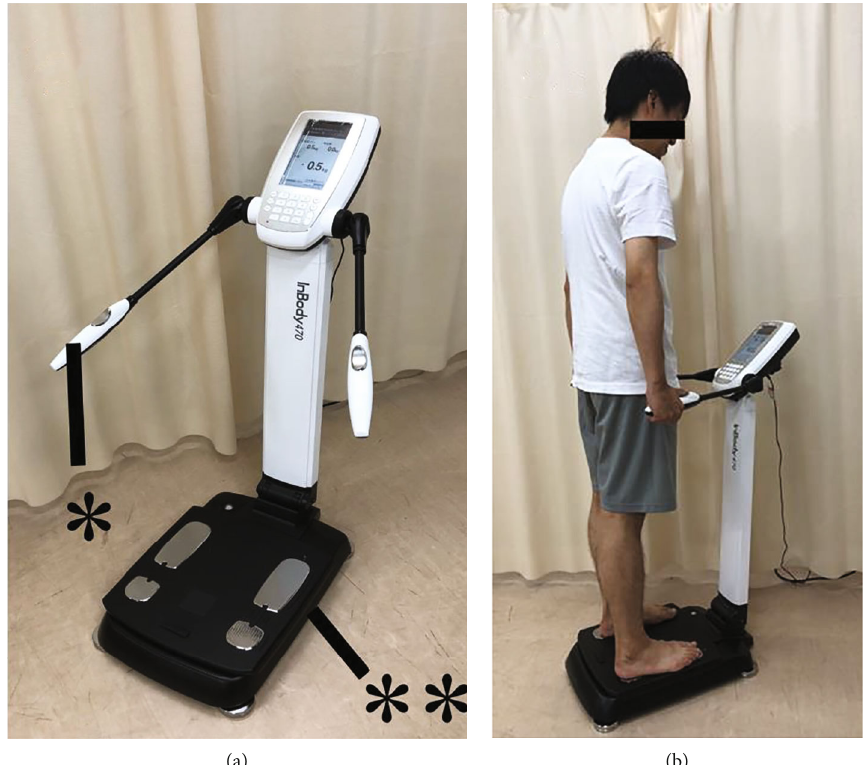
Figure 1: Method for measuring body composition. (a) Image of the InBody 470®; ∗ : hand electrodes; ∗∗ : foot electrodes. (b) Measurement of body